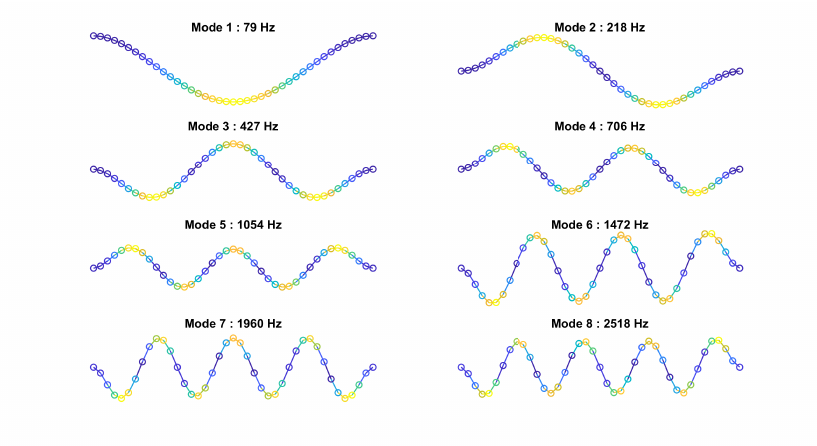
Figure 2. Linear normal modes of the flat beam. Modes 1 and 3 are used within the base